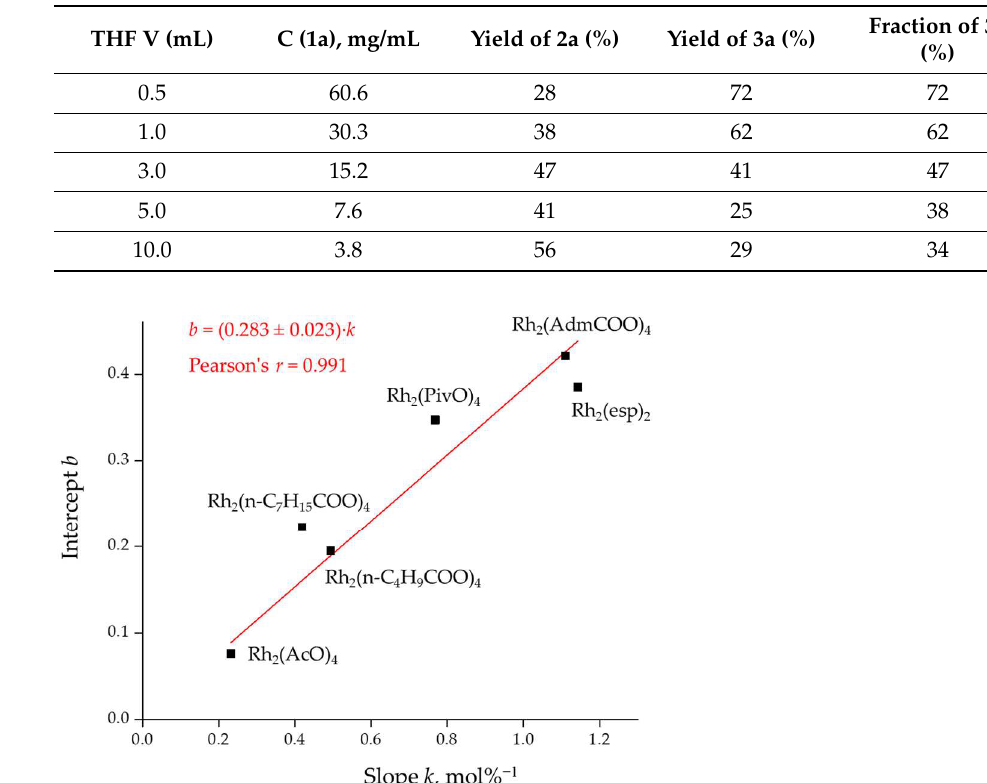
Table 2. Outcome of 1a → 2a + 3a reaction performed at different dilutions.